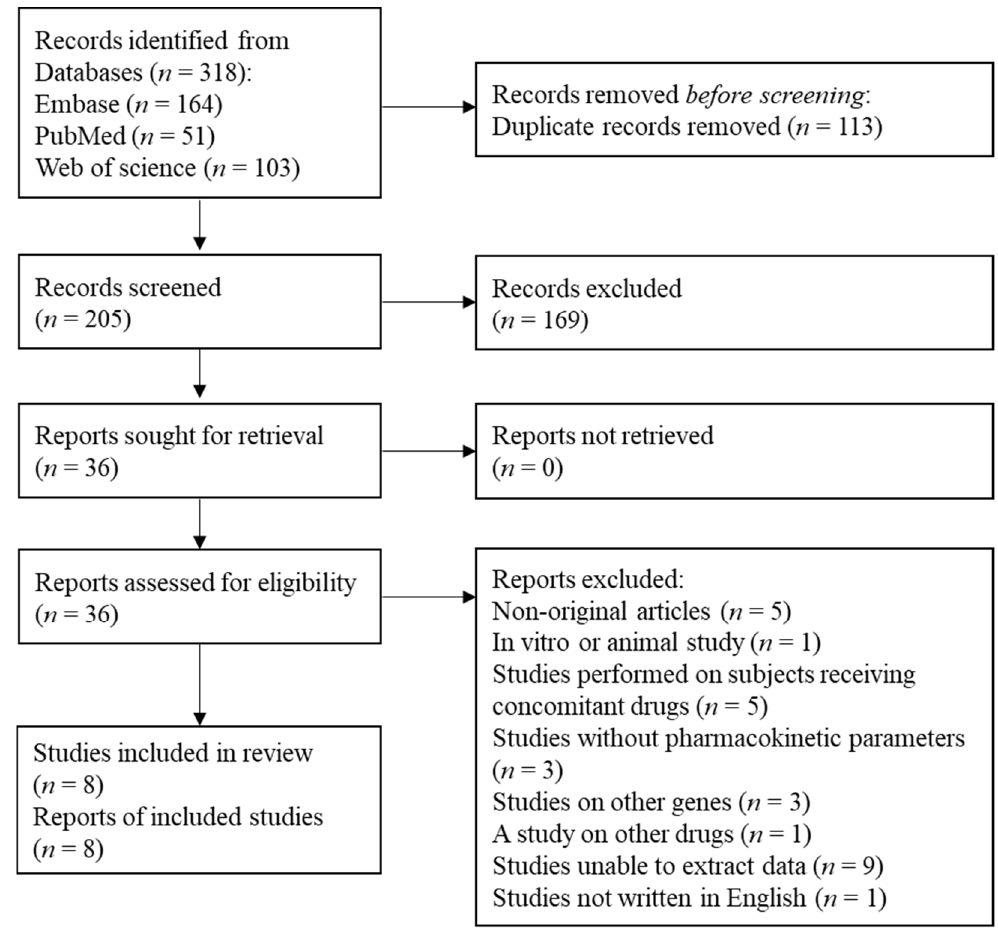
Figure 1. Preferred reporting items for systematic reviews and meta-analyses (PRISMA) flow diagram of the study selection.